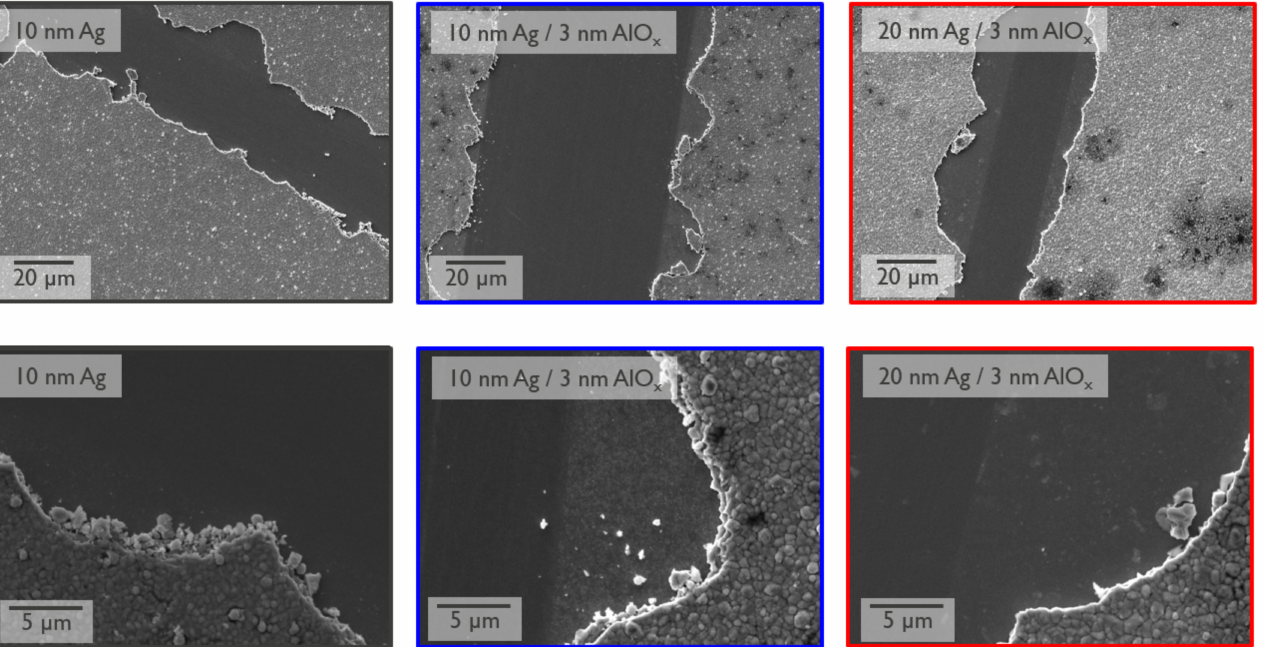
Figure 6. SEM images of the solar cell and a scratch. The scratch itself also removes the AlO x ( top ), but at the edges the CIGS peels off, leaving the Ag/AlO x back exposed ( bottom ).